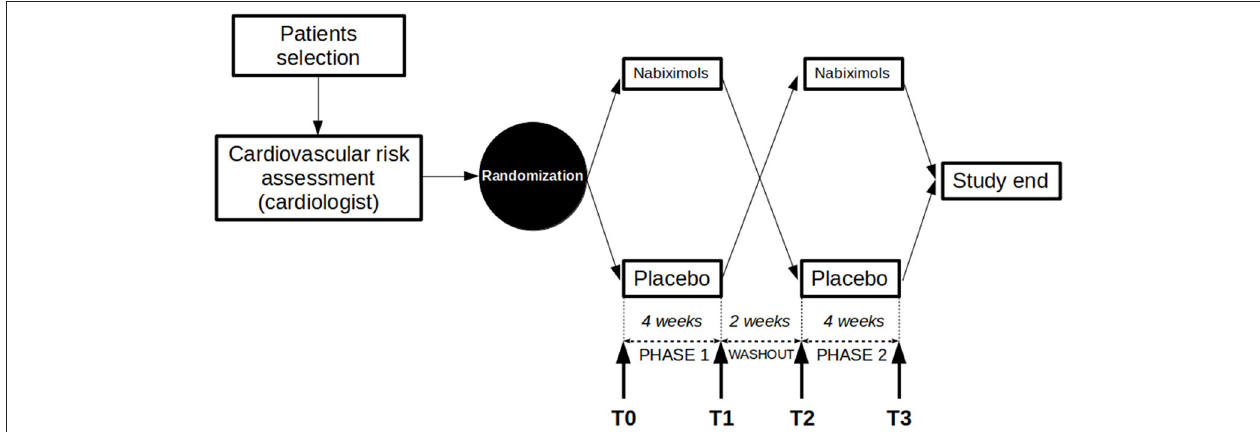
FIGURE 1 | Study protocol design. Study crossover design is represented. After checking for inclusion/exclusion criteria and passing the cardiological evaluation, patients were randomized to placebo/nabiximols or nabiximols/placebo arms. The two phases of the study were separated by a washout period, started with visits T0/T2 and ended with visits